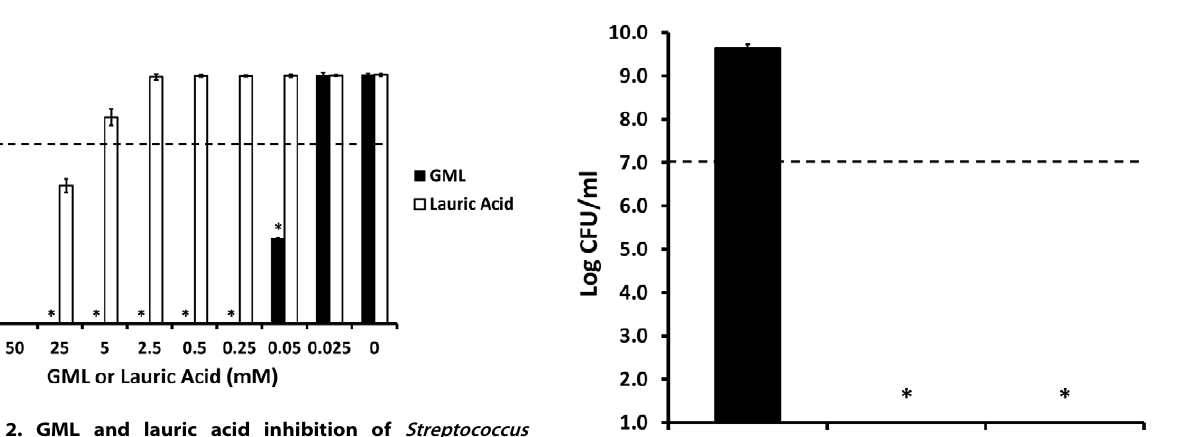
Figure 2. GML and lauric acid inhibition of Streptococcus pyogenes growth. GML and lauric acid were incubated with approximately 5 6 10 6 CFU/ml of Streptococcus pyogenes for 24 hours stationary in the presence of 7% CO 2 at 37 u C in triplicate. Plate counts were used to determine CFUs/ml. Bars show standard deviations. Bactericidal activity was defined as the minimum concentration of agent required to reduce CFUs by $ 3 logs. * indicates GML mean significantly different from lauric acid mean with p , 0.001. Dashed line indicates starting inoculum size.